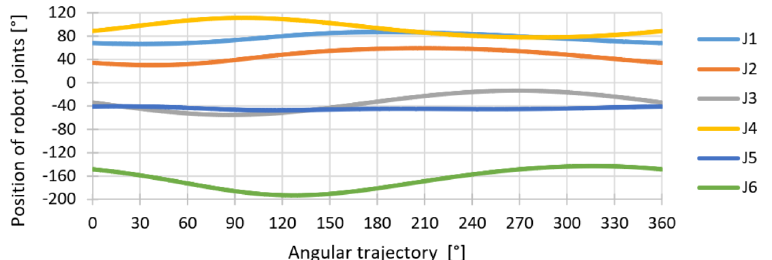
Figure 8. The course of the motion of the individual robot joints during the TCP movement in a circular path in the inclined plane.